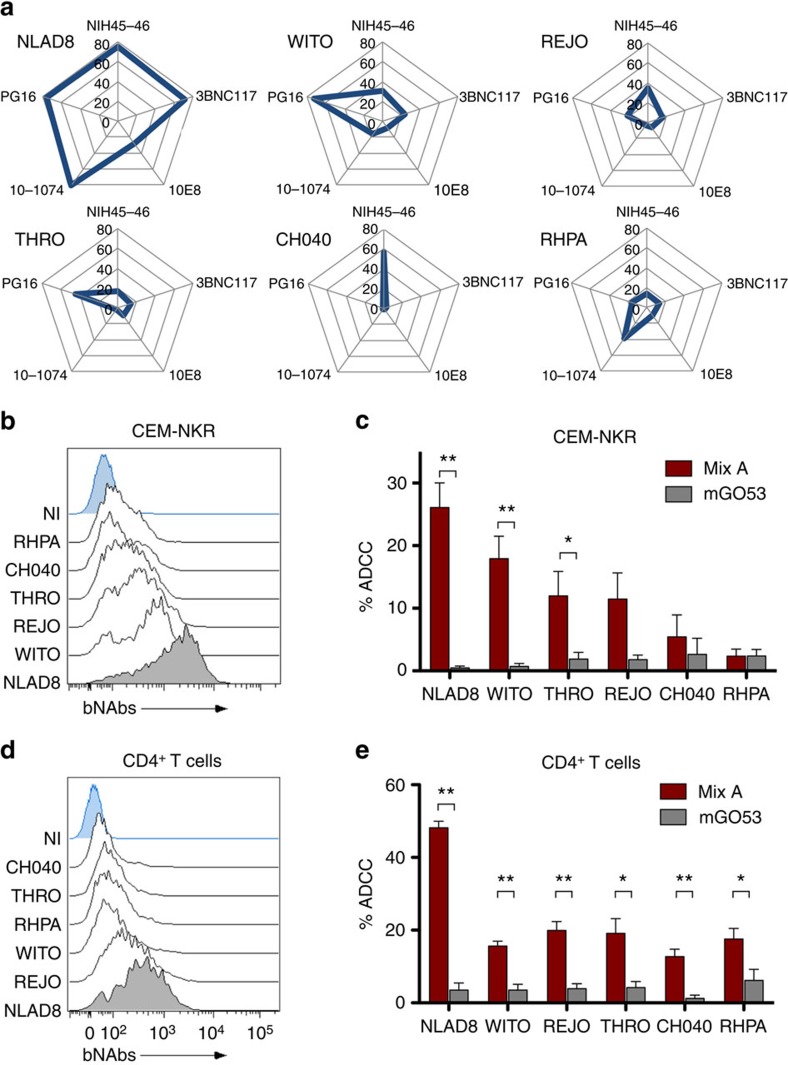
Binding of bNAbs and ADCC activity against lymphocytes infected with various HIV-1 strains.(a) CEM-NKR cells infected with the indicated HIV-1 (NLAD8 or five Transmitted/Founder HIV-1) were incubated with the five indicated bNAbs at 4 °C and surface levels were analysed by flow cytometry. The radar plots indicate the % of bNAb+ cells among infected (Gag+) cells. One representative experiment (out of four) is shown. (b) The binding of a combination of the five bNAbs (MixA: NIH45–46; 3BNC117; 10E8; 10–1074 and PG16) to the surface of CEM-NKR cells infected with various HIV-1 (NLAD8 or five T/F HIV-1) was determined by flow cytometry among Gag+ cells. One representative experiment (out of four) is shown. (c) CEM-NKR cells infected with the indicated HIV-1 strains were incubated with MixA or with mGO53 control antibody and with NK cells. After 6 h, the % of Gag+ CEM-NKR target cells was measured by flow cytometry. The % of ADCC was calculated as the disappearance of Gag+ cells (N=6 experiments; Error bars indicate s.e.m. and significance was determined by comparing MixA to mGO53; **P<0.01; *P<0.05, Wilcoxon test). (d) The binding of MixA to the surface of primary CD4+ T cells infected with various HIV-1 (NLAD8 or five T/F HIV-1) was determined as in b. (e) The ADCC activity of MixA against primary CD4+ T cells infected with the indicated HIV-1 strains was determined as in c.